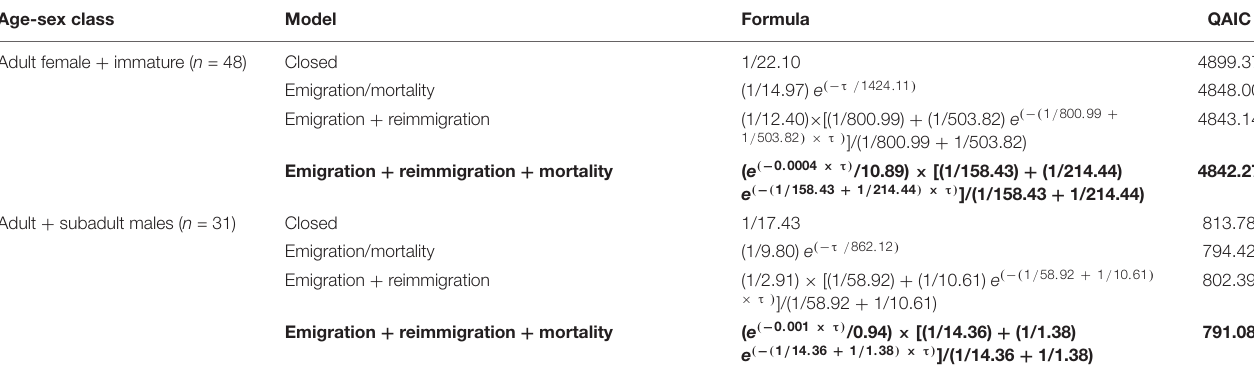
TABLE 3 | Models fitted to Lagged Identification Rates (LIR) for adult females and immatures, and for adult and subadult males of Blainville’s beaked whales captured between 2015 and 2019.